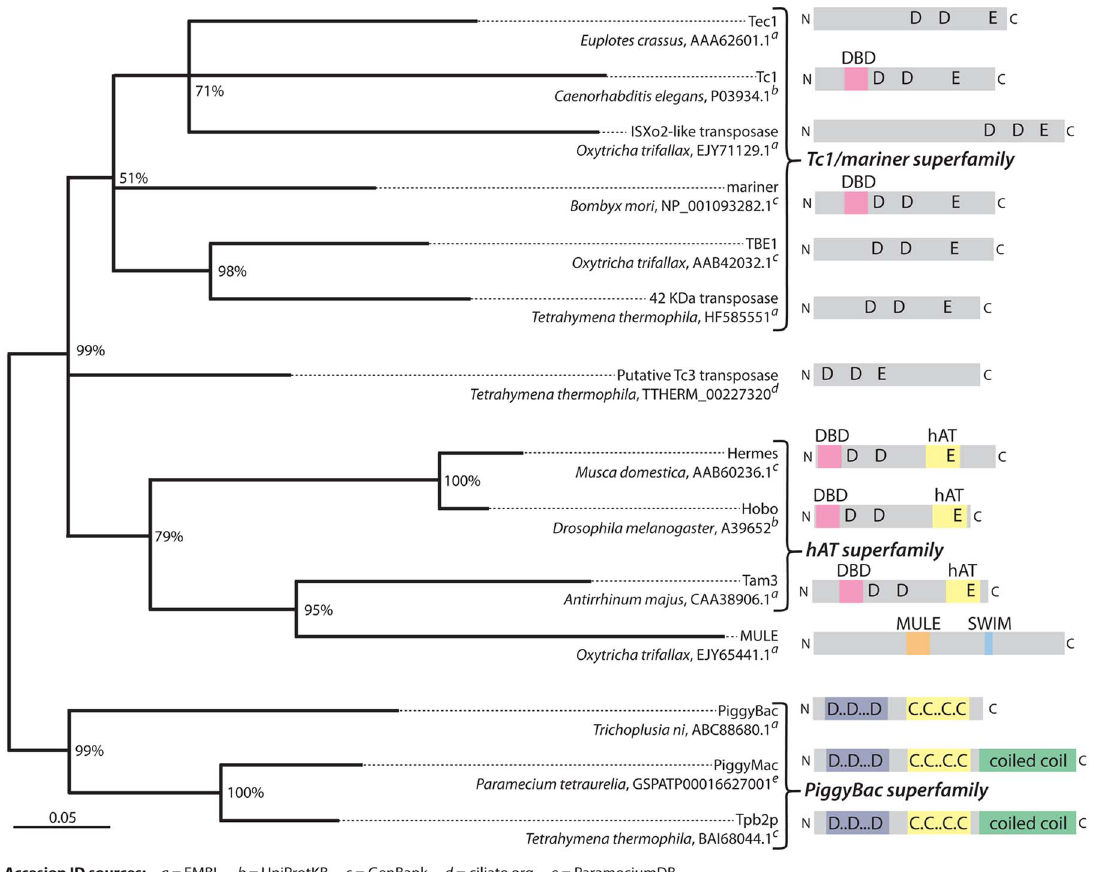
Figure 4. Phylogenetic analysis of representative transposases of the DDE/DDD superfamily. This tree supports the conclusion that TBE elements belong to the Tc1/ mariner superfamily of transposons and also that there appear to be TBE-like elements present in Tetrahymena (labeled ‘‘42 kDa transposase’’). Additionally, this analysis supports the conclusion that the two PiggyBac-like transposases, Pgm and Tpb2p, in Paramecium and Tetrahymena are homologous to each other. The grouping of the MULE family representative [17] within hAT transposases is unexpected [47] and possibly the result of an alignment artifact due to its disproportionately long sequence. Recently discovered Paramecium transposases Sardine, Thon, AnchoisA, and AnchoisB [29] were omitted because their inclusion in the analysis significantly lowered confidence scores for a majority of branches. The tree was created with MRBayes phylogenetic inference software [48] using the alignment shown in Dataset S1, which was edited to remove regions with gaps in the consensus sequence. The phylogeny was generated using a mixed amino acid substitution model and invariable gamma distribution rate model over 200,000 iterations with a burn-in of 25%. Branch confidence values represent conditional probabilities generated by the Bayesian inference process. The scale bar corresponds to 0.05 expected substitutions per site of the unmasked alignment positions. Domain and motif annotations were produced using the Pfam web server [49].